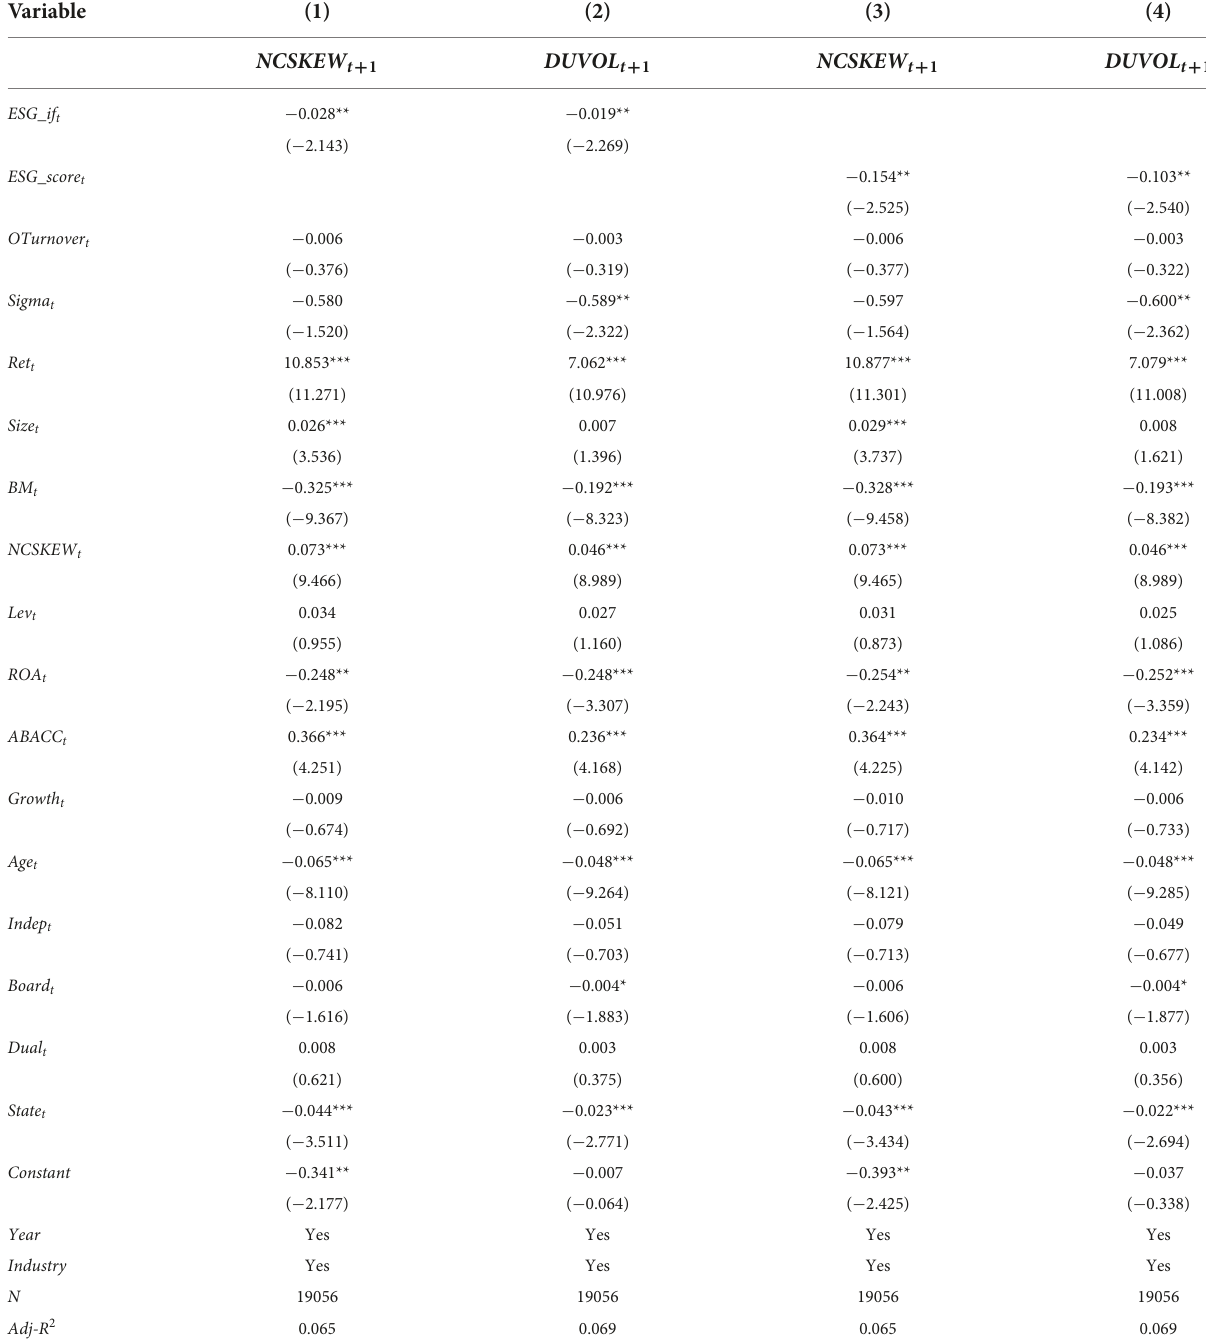
TABLE 2 Baseline regression